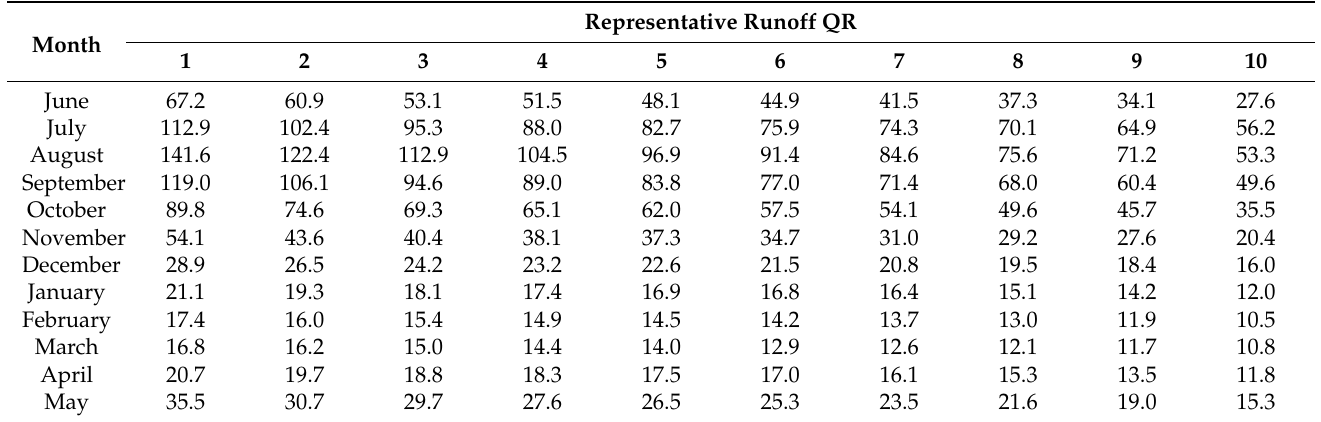
Table 3. Representative runoff in each month for measured runoff of the NZD hydropower plant (10 8 m 3